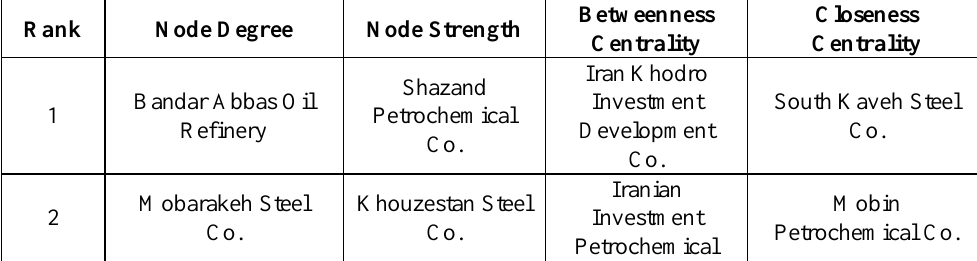
Table 4: The first 5 companies in the central